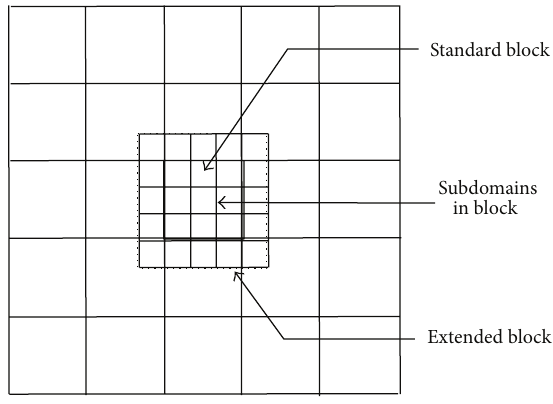
Figure 2: Blocks and